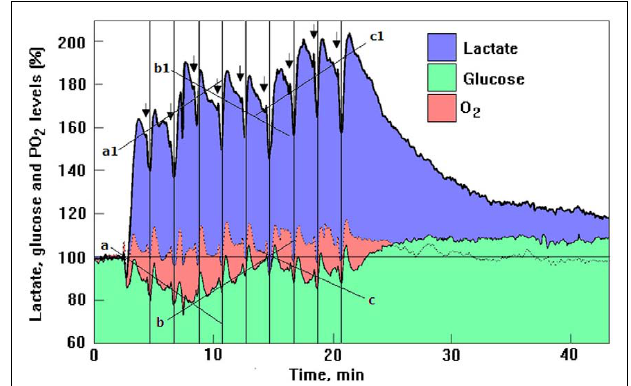
FIGURE 2 | Profiles of time course and dynamic relationships of local extracellular lactate, glucose, and PO 2 levels in the rat hippocampal dentate gyrus during a series of 5s electrical stimulations (arrows) of the perforant pathway at 2min rest intervals (reproduced with permission from Hu andWilson, 1997b; copyright 1997, Blackwell, Oxford). The different diagonal lines show the trend in the mean analyte concentration during the series of stimulations. During the second to the fourth stimulations as glucose mean level gradually decreased (line a), lactate mean level gradually increased (line a1). During the next three stimulations the trend was inverted (lines b and b1) and during the 7th to the 10th stimulations the trend inverted itself again (lines c and c1).The changes in the mean concentration of glucose were always in opposite direction to the changes in mean lactate concentration.The vertical lines were drawn to indicate the simultaneous dip in all three analytes in response to each of the 10 electrical stimulations. For additional details see Hu andWilson (1997b).